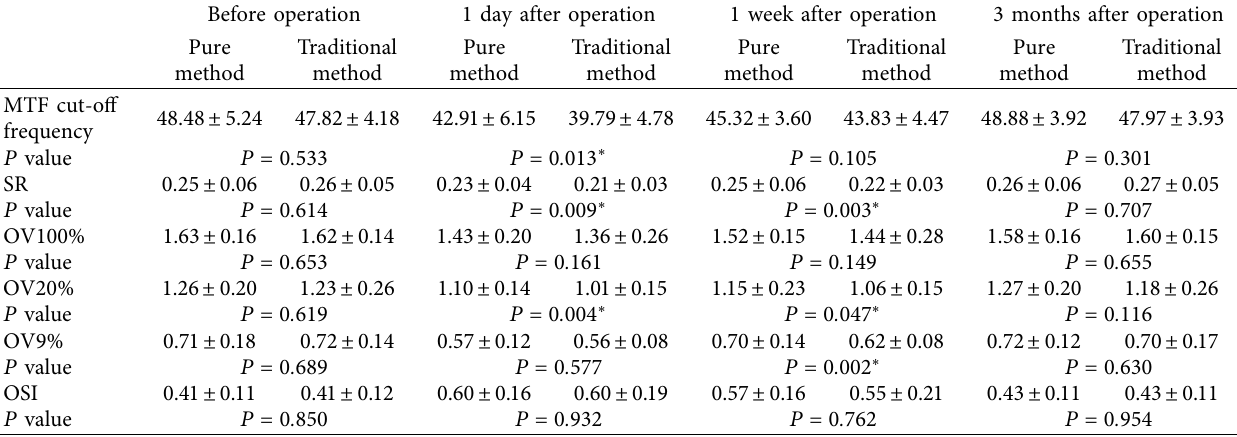
Table 5: Time courses of the visual quality indicators in the pure ICL implantation and traditional ICL implantation groups. Before operation 1 day after operation